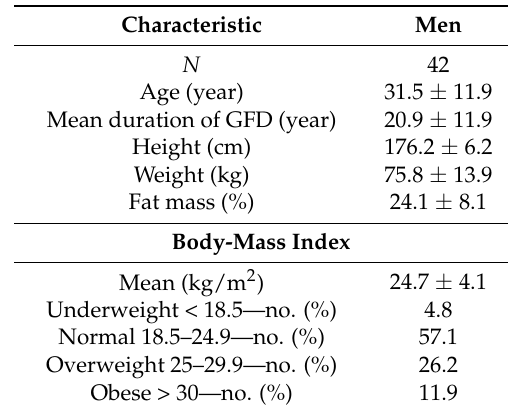
Table 1. Characteristic of celiac participants included in the survey.